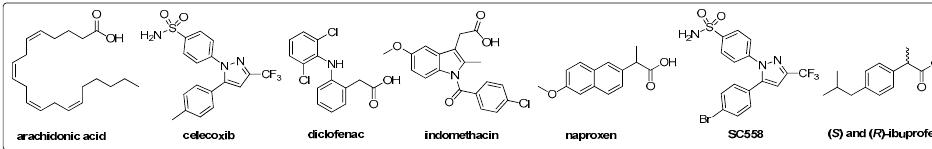
Figure A1. Structures of natural ligand and selective and non-selective COX-2 Figure 1. Structures of natural ligand and selective and non-selective COX-2 inhibitors.